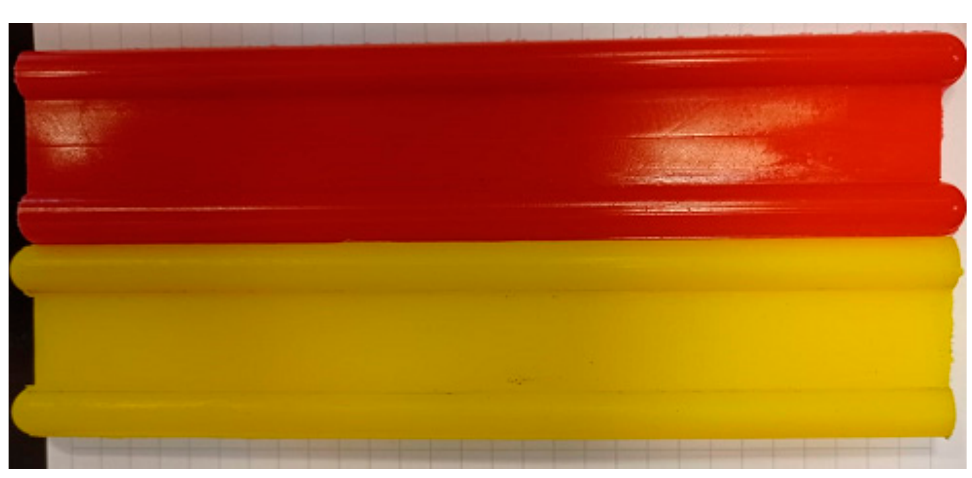
Table 1. Tensile test results analysis for 80 ShA and 90 ShA material con fi guration based on [21].